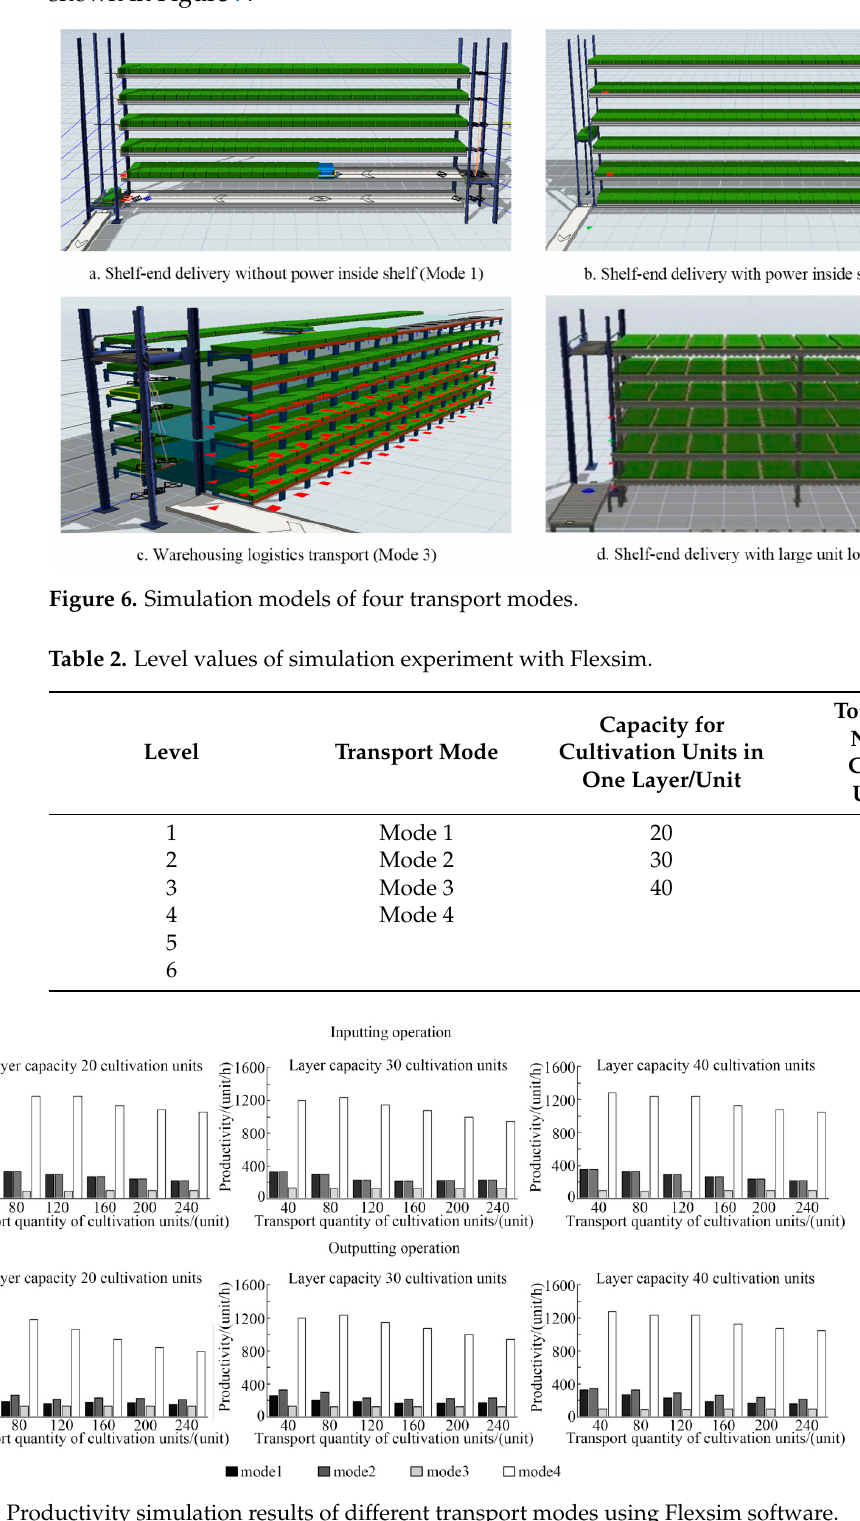
Figure 7. Productivity simulation results of different transport modes using Flexsim software .